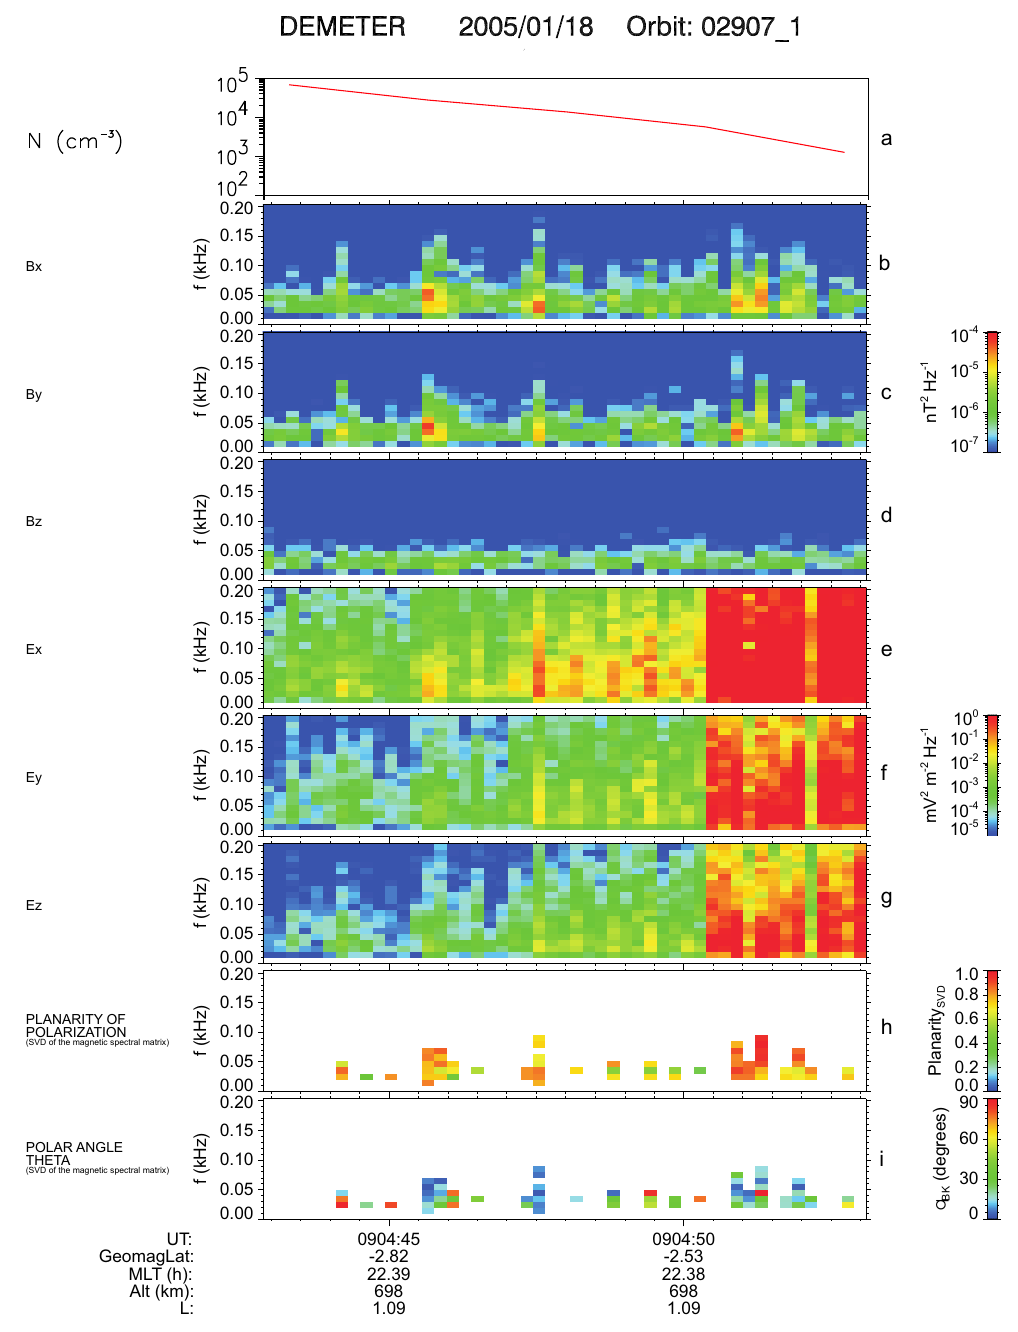
Fig. 1. The 10s high resolution overview of the DEMETER crossing of a plasma bubble edges described in the text. The ox axis is directed eastward, oy upward and oz along the magnetic field